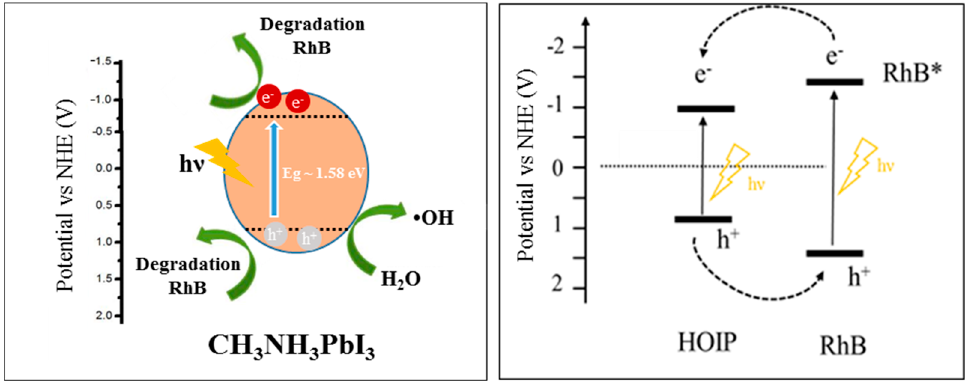
Figure 11. Proposed band gap energy diagram and charge transfer between RhB and photo-catalyst.